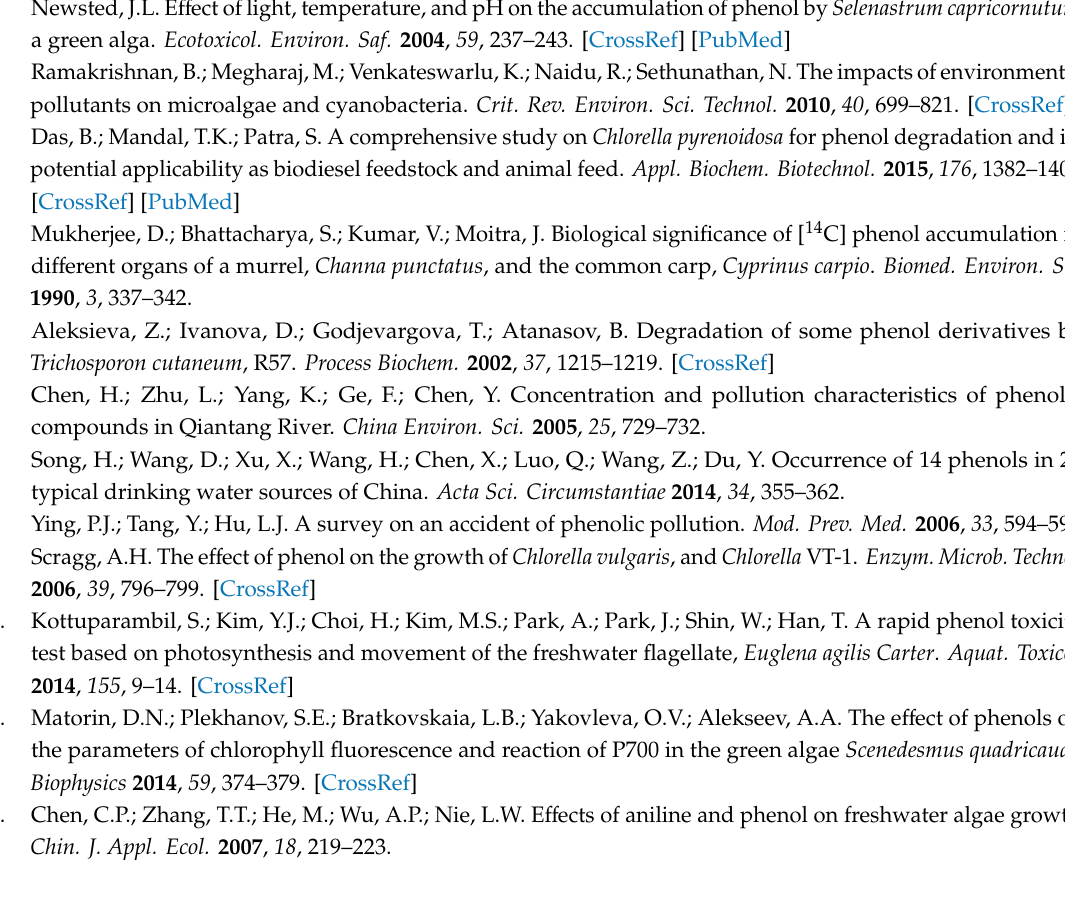
Table S1: Changes of the dissolved phenol concentration ( µ g mL − 1